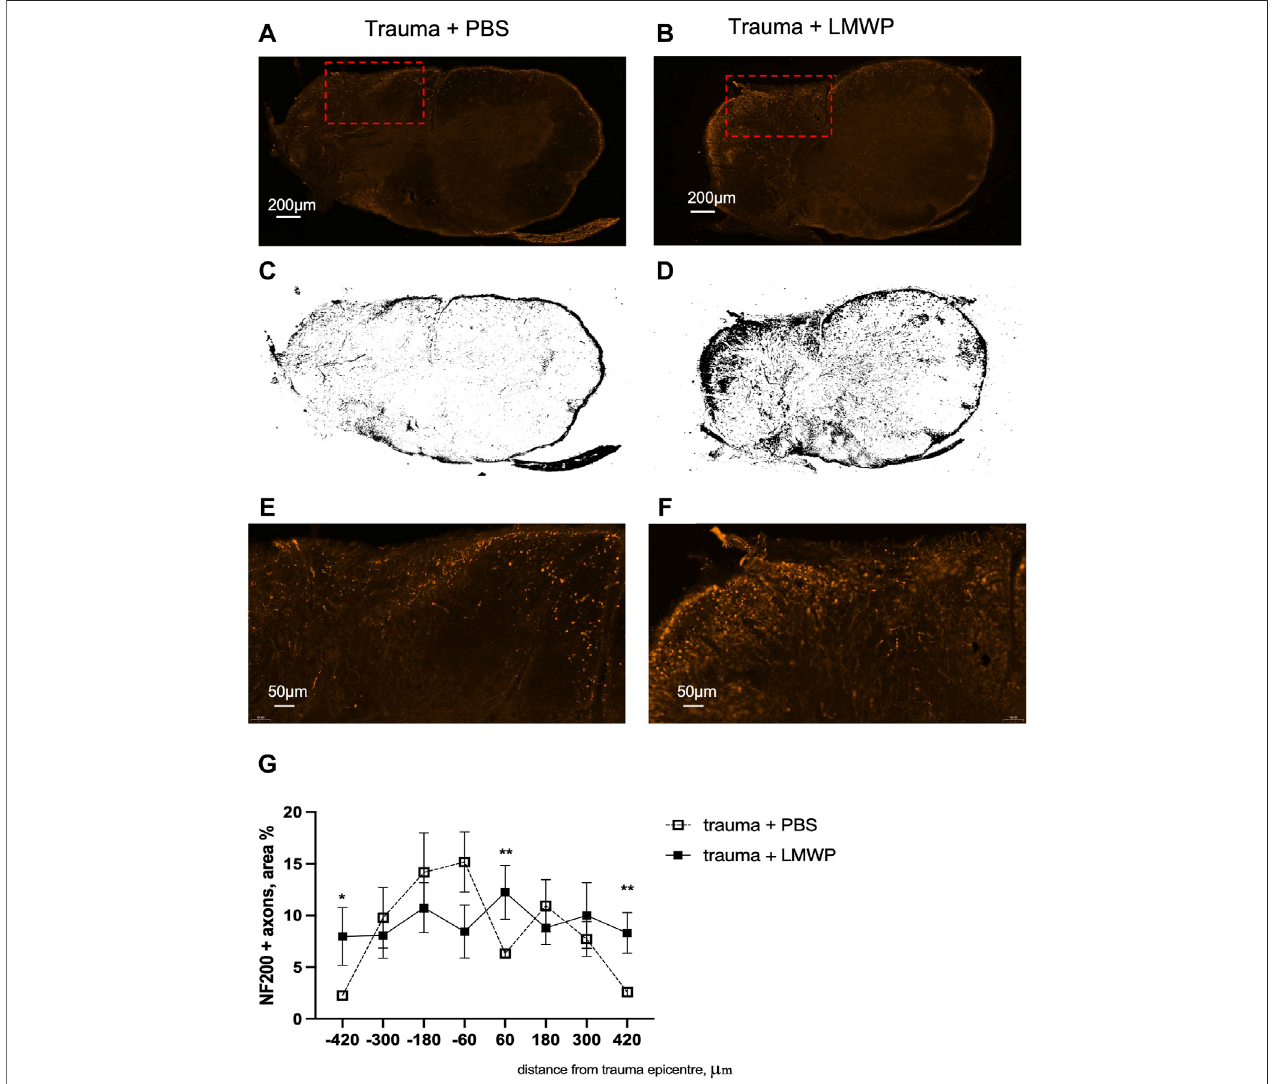
FIGURE 9 | Immunohistohemical staining for NF200+. (A,B) Representative images of transverse spinal cord section stained for NF200+ in PBS and LMWP treated mice at the week 12 after hemicontusion trauma induction (scale bar is 200 µm). Red rectangle marks the area enlarged in panel (E,F) . (C,D) Corresponding thresholdimages from thesections ofPBS-and LMWP-treated animals. (E,F) EnlargedviewoftheNG200+ fi bers inPBSand LMWP treatedmouse spinalcords (scale bar is 50 µm). (G) LMWP treated animals had more NF200+ axons in sections located on the periphery of the trauma epicenter. * p < 0.05, *** p < 0.001 Mann- Whitney compared to the same area within trauma + PBS group; n = 7 –